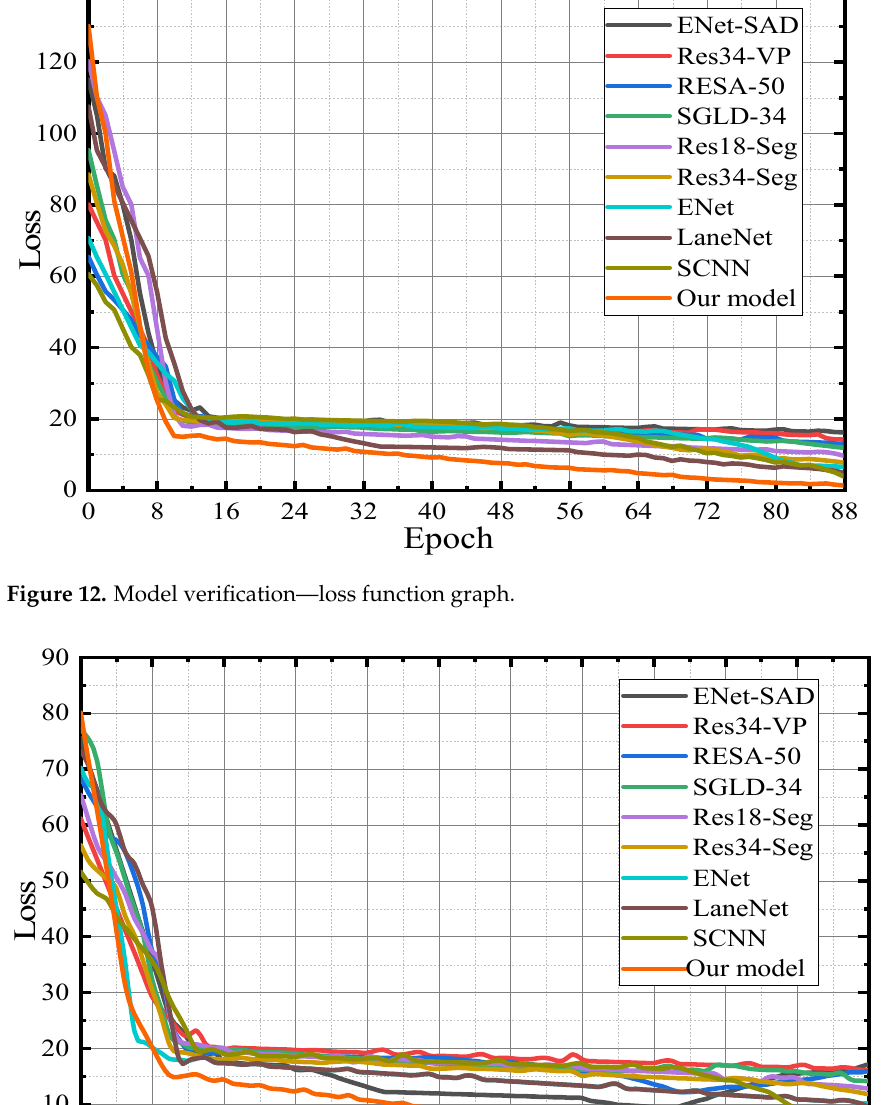
Figure 12. Model verification—loss function graph.